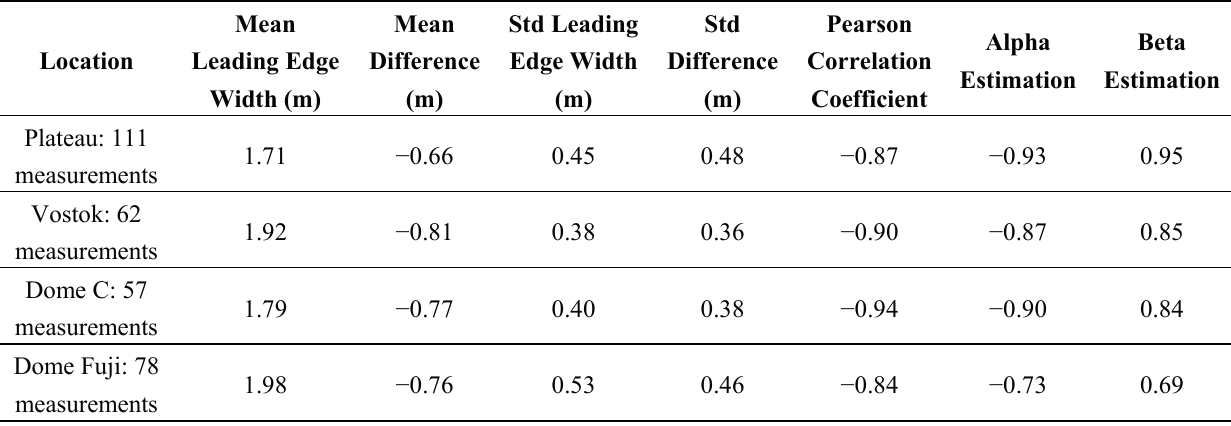
Table 1. Table of values for the Pearson correlation coefficient and the linear model for the leading edge width and the elevation difference for the four areas with the backscatter coefficient and the trailing edge slope